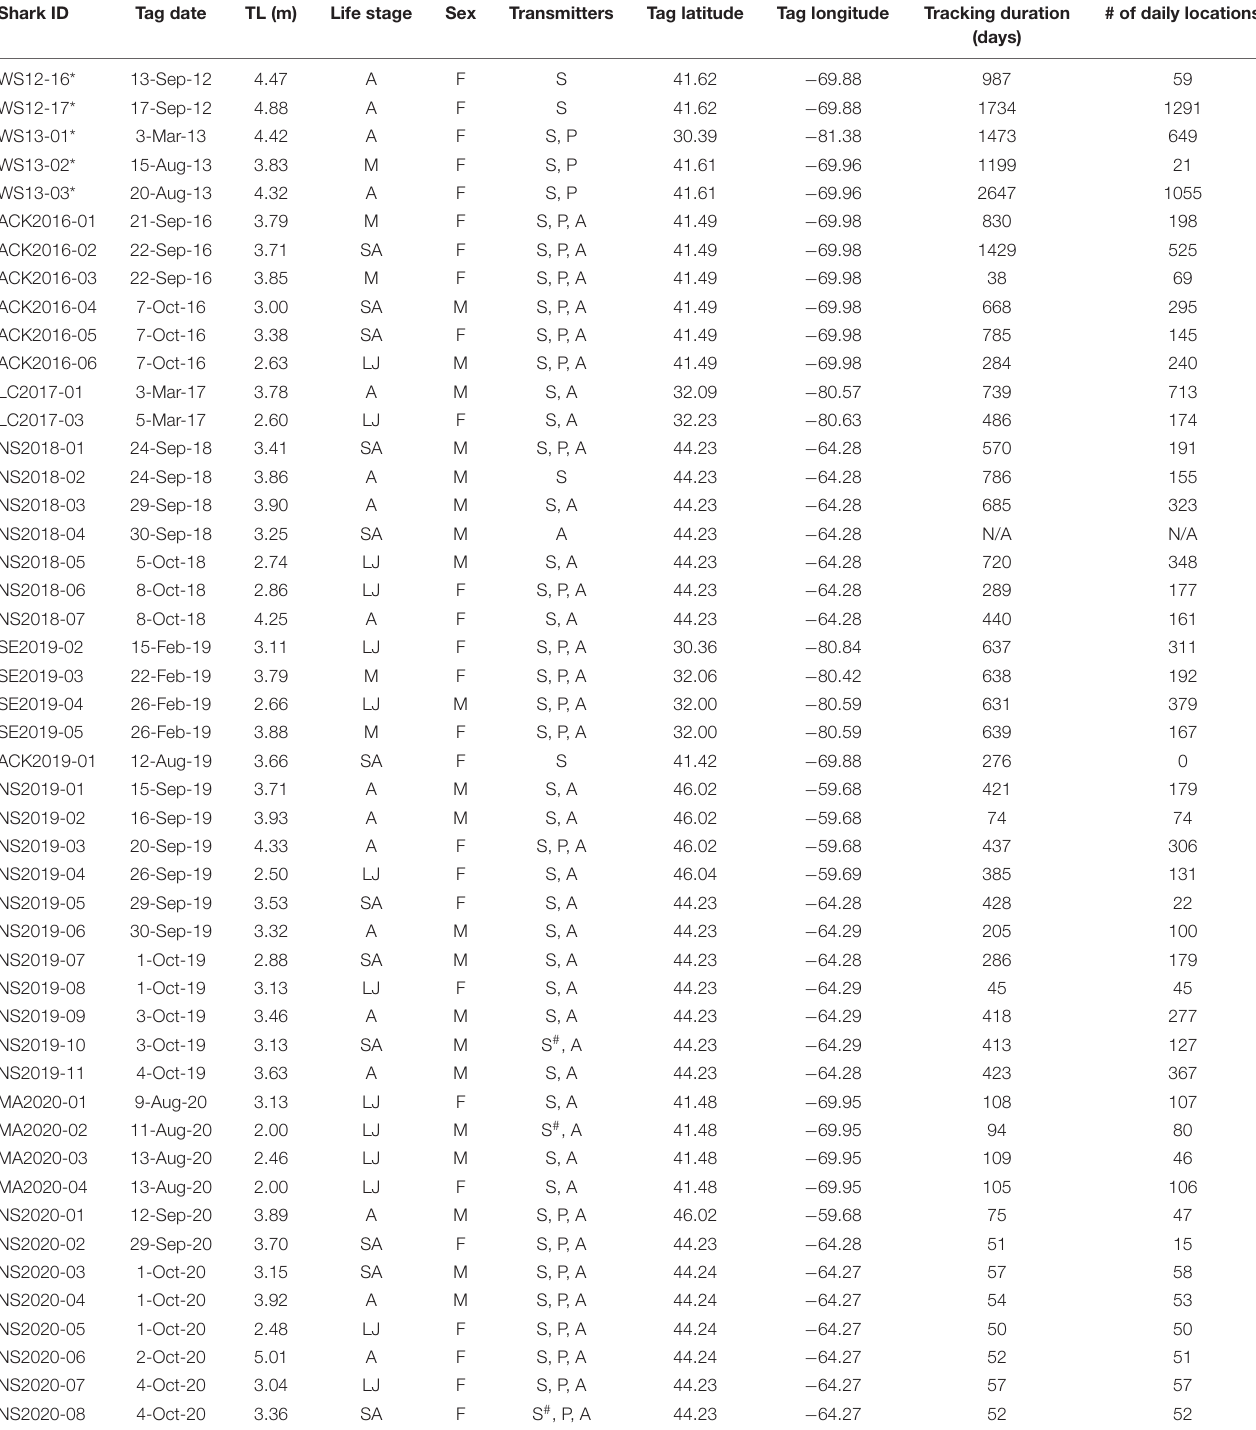
TABLE 1 | Summary data for tracked